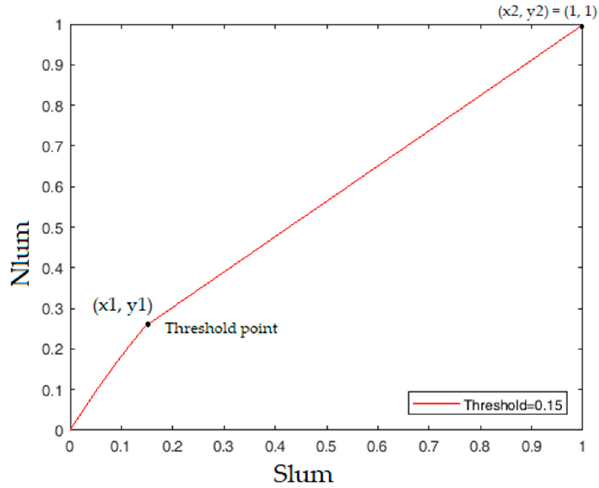
Figure 4. Behavior of Nlum above and below threshold point.